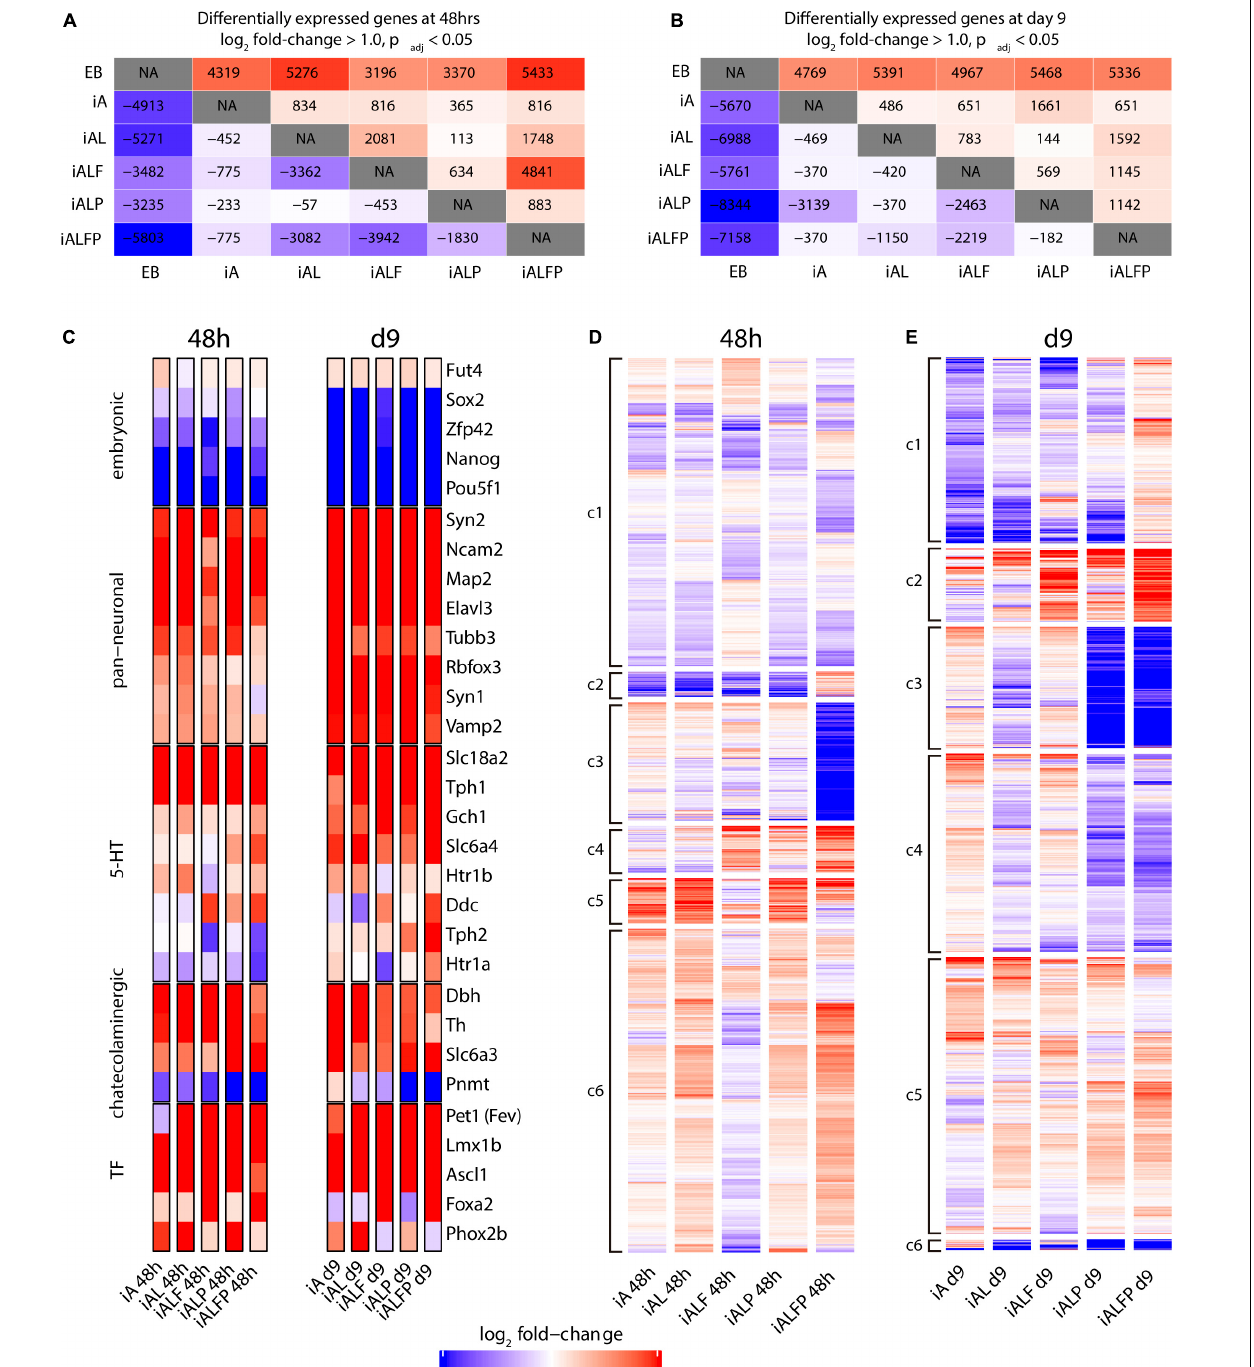
Frontiers in Neuroscience |